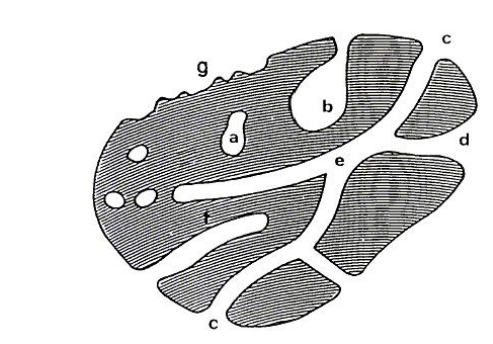
Fig. 2 Schematic pores classification, according to their availability to surroundings (mod- ified from IUPAC [10]) a - closed pores, b, f - pores open only at one end, c, d, g - open pores, e - open at two ends (through)